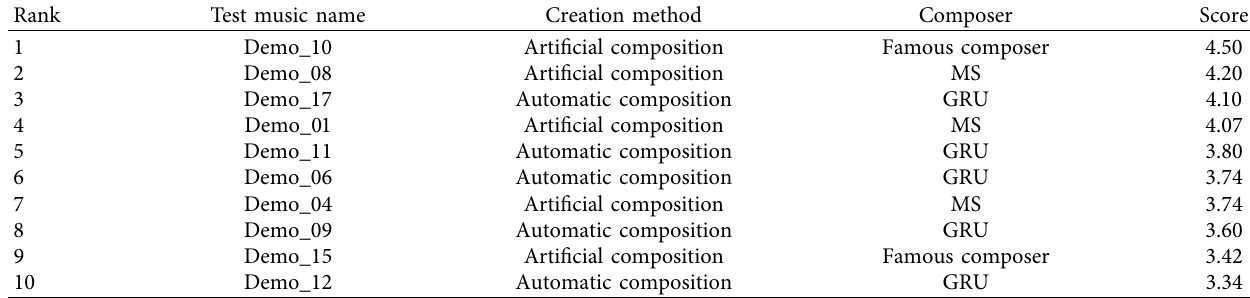
Table 2: Top 10 online scores.